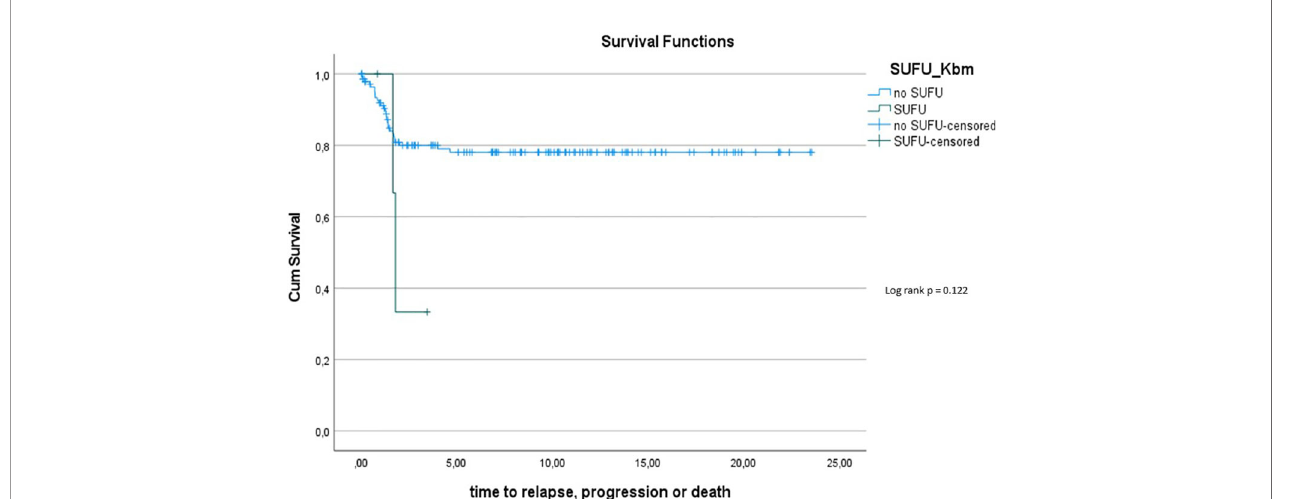
FIGURE 8 | PFS for all SHH+, MBEN/DMB <3.5 vs. SUFU mutated Gorlin patients.